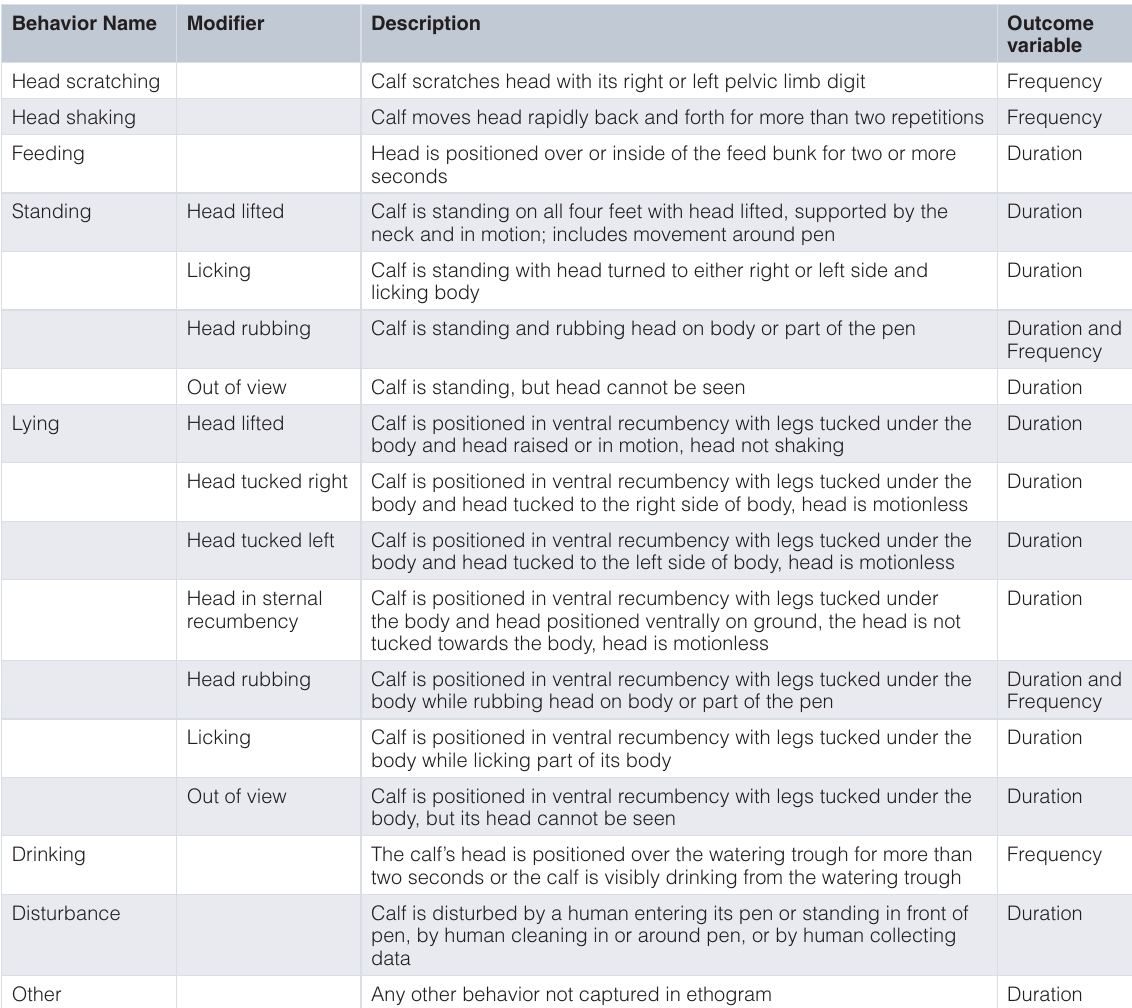
Table 1. Ethogram for observing recorded video using Observer® (v10.1.548, Noldus Information Technology, Wageningen, NL) software for all trials and treatments during baseline and scarification time